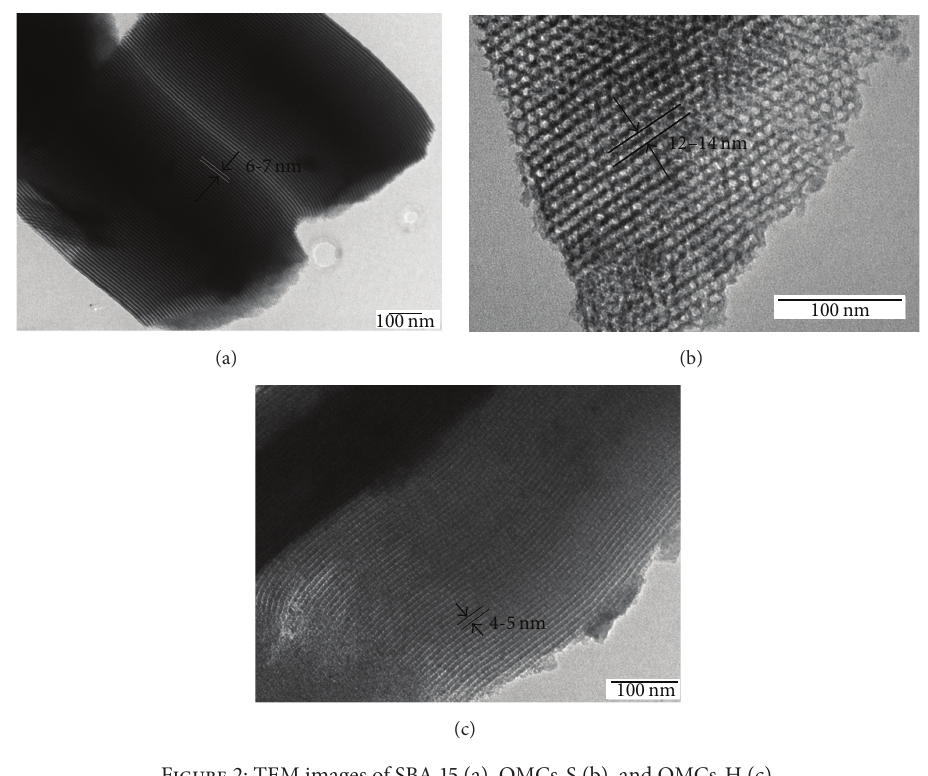
Figure 2: TEM images of SBA-15 (a), OMCs-S (b), and OMCs-H (c).